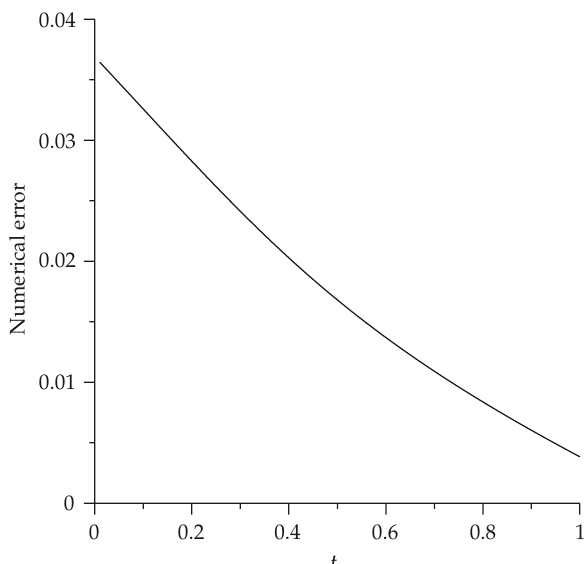
Figure 6: Showing the numerical error for example